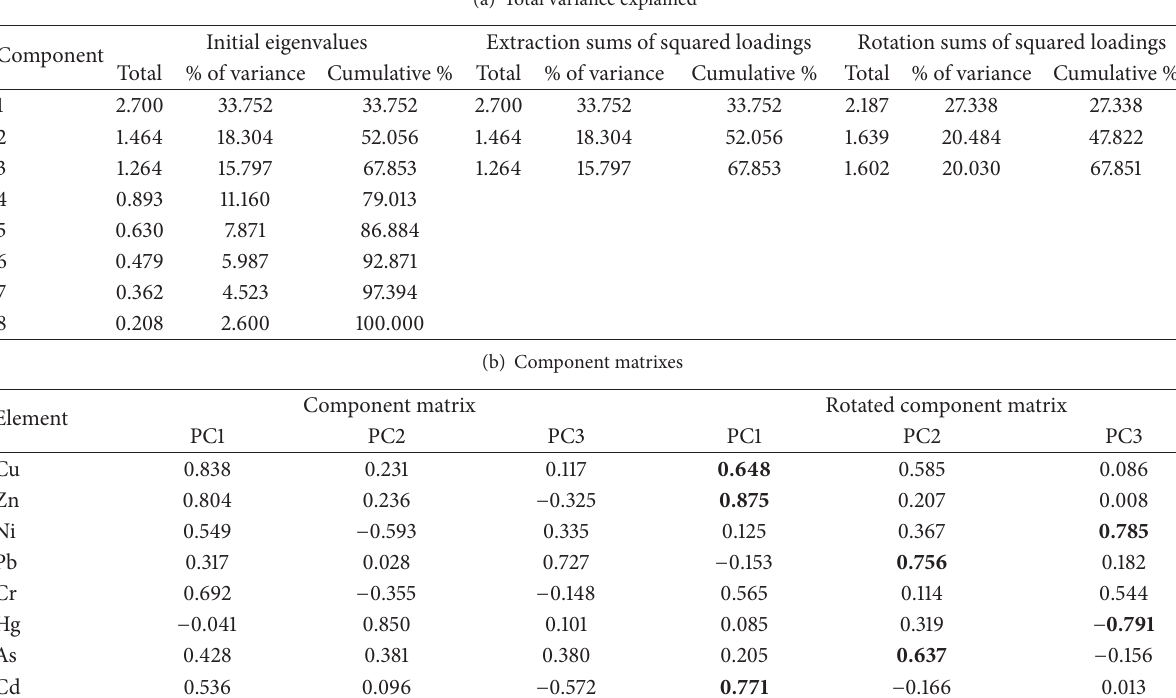
Table 1: Total variance and component matrixes (three factors selected) for heavy